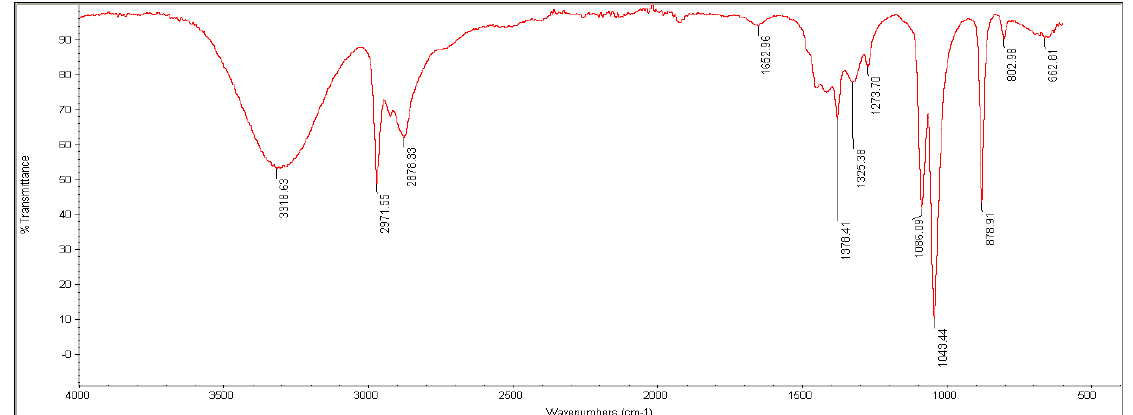
Figure 15. IR spectrum of chelidonine. Table 3 .The FTIR spectrum regions indicated the major functional groups in compound